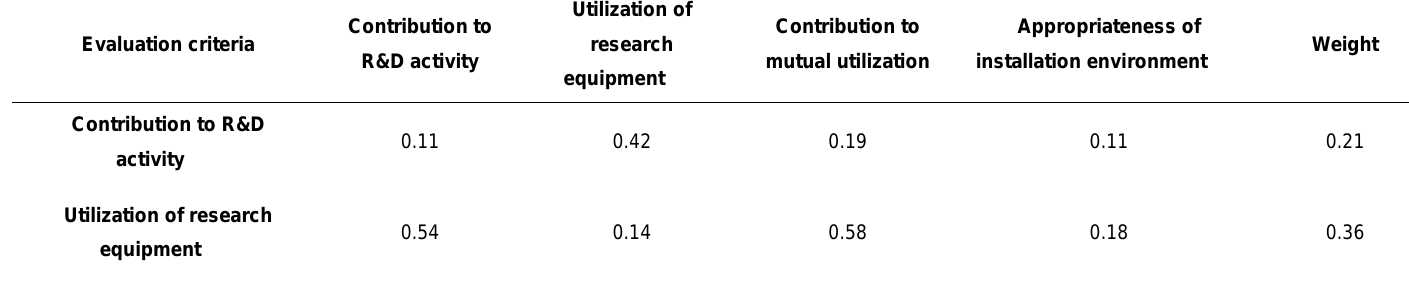
Table 12. Weights of the evaluation